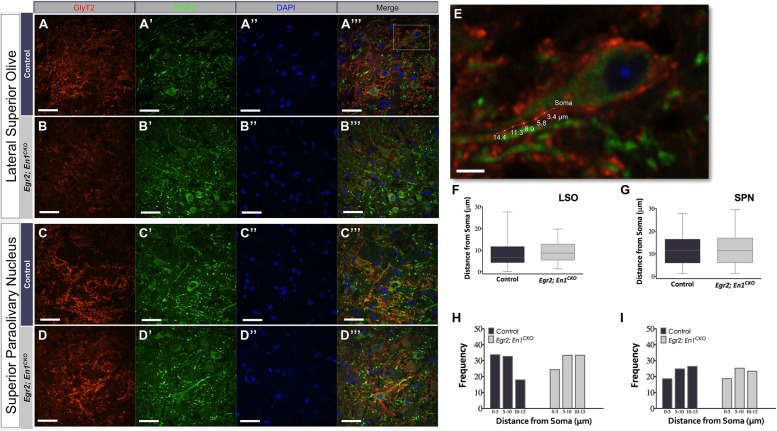
Dendritic localization of GlyT2+ boutons is unchanged in adult Egr2; En1CKO mice. GlyT2+ boutons were present on MAP2+ dendrites of LSO and SPN neurons in adult control (A–A″′,C–C″′) and Egr2; En1CKO mice (B–B″′,D–D″′). (E) Area outlined by the white box in (A″′). Distance of GlyT2+ boutons from neuronal soma was measured as shown. Box plots depicting the median and distribution of bouton distance from cell somata in LSO (F) and SPN (G). Whiskers are representative of minimum and maximum distance values. Data were further analyzed by looking at proximal vs. distal localization by determining the frequency (percentage) of boutons in 5 μm increments for dendrites in the LSO (H) and SPN (I); no significant differences were present between control and Egr2; En1CKO mice. Scale bars: 33 μm (A–D″′); 16 μm (E).